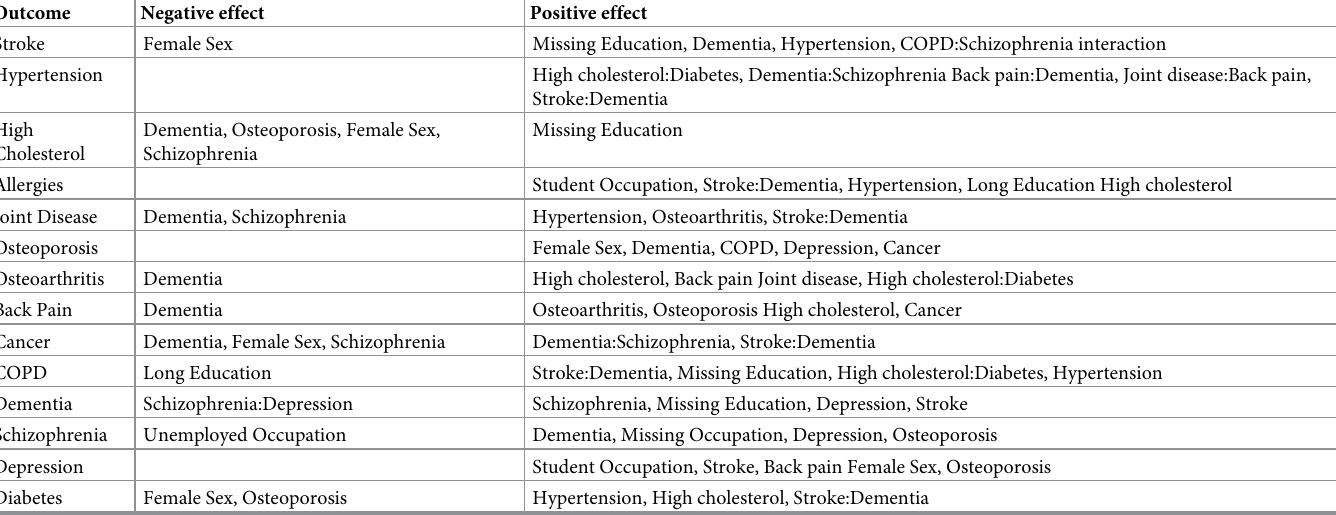
Table 6. Most important variables for transition probabilities. Top five significant (1%) variables with the largest discriminative power across different next diagnosis endpoints as measured by the absolute size of the coefficients in the logistic regression models. The variables are presented by the coefficient sign, where a positive (nega- tive) coefficient corresponds to an increased (decreased) probability of the outcome relative to the other possible outcomes. A colon gives coefficients related to the pres- ence of two simultaneous diseases (Disease 1:Disease 2).